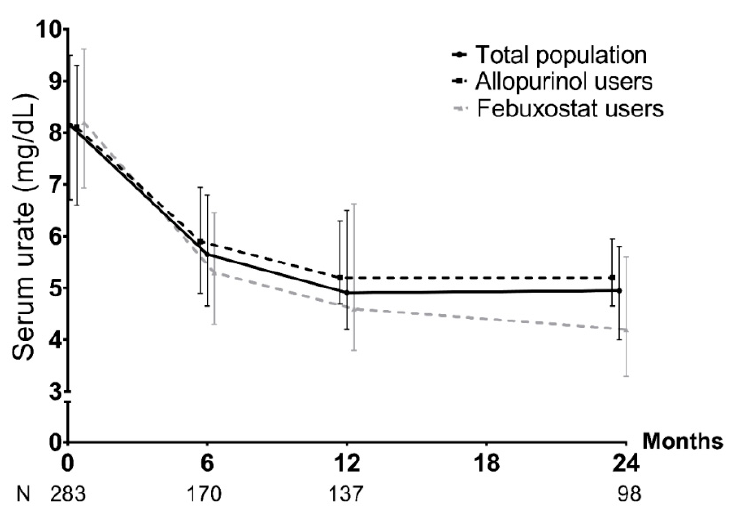
Figure 2. Evolution of median serum-urate level and interquartile range [Q1–Q3] during the follow- up. N = total number of patients with an available serum-urate measurement at the visit.